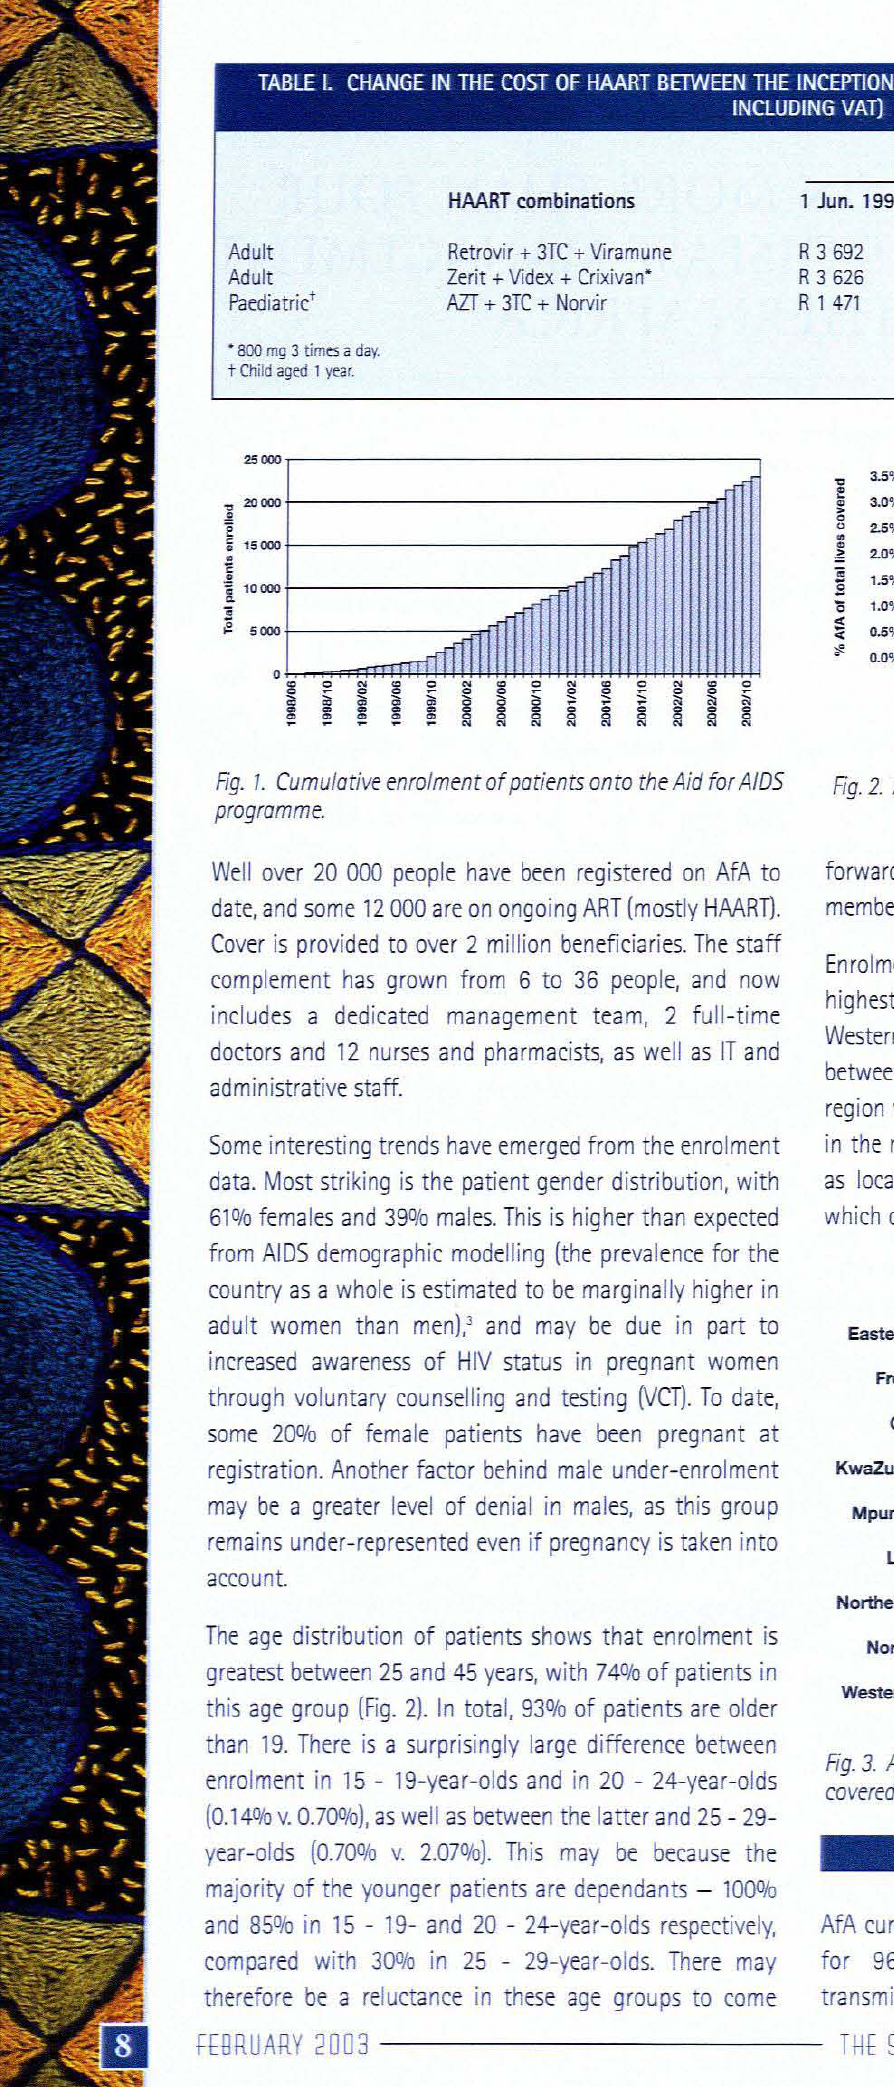
Fig. 3. Aid for AIDS en raiment by region {% total lives covered}.